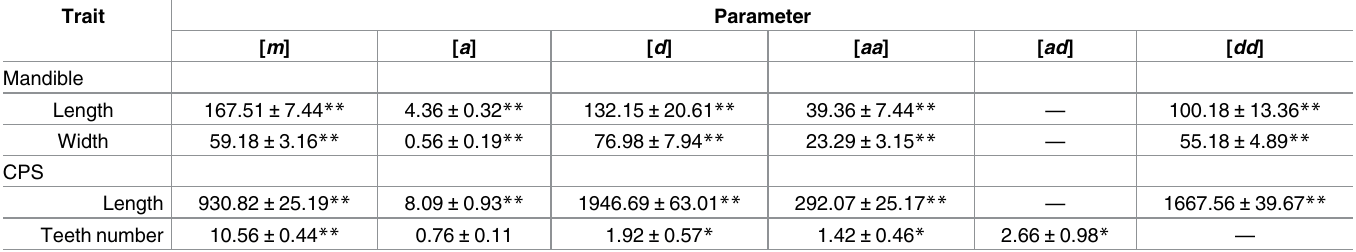
Table 2. Estimation of additive, dominance and epistasis parameters for mandible length and width, CPS length and teeth number in D . gaucha larvae. The individuals were192 h of development. Goodnessof fit of an additive-dominant-epistatic modelto the collecteddata was performed(Chi-squared test values are listed in S1 Table). Probabilities showingsignificanceof the calculatedparameters are given at bottom of the Table, and the correspondingt- values are listed in S2 Table. For all crosses the parentallines were the Buenos Aires (BA) and Campos de Jordan (CJ)